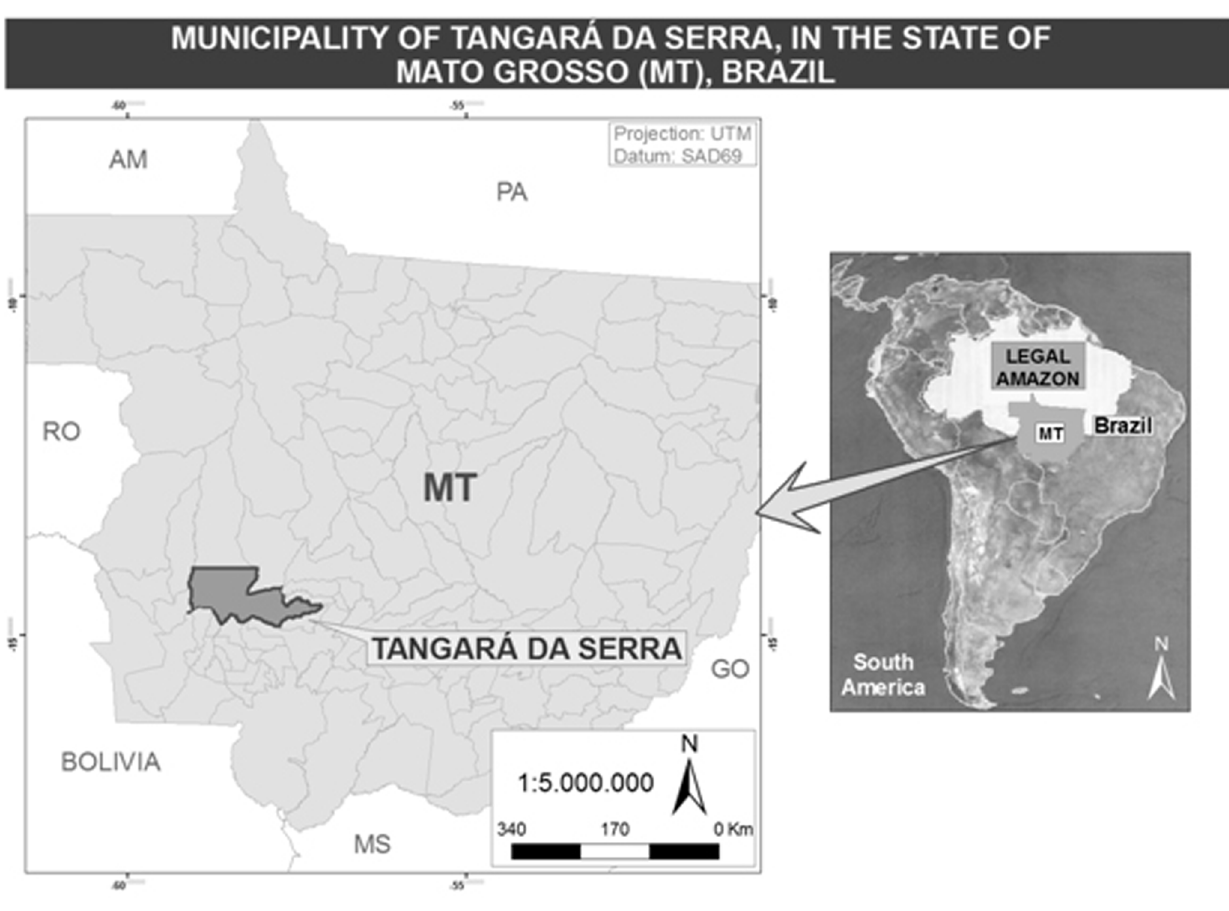
Figure 1. Geographic location of the municipality of Tangara´ da Serra, Mato Grosso State.